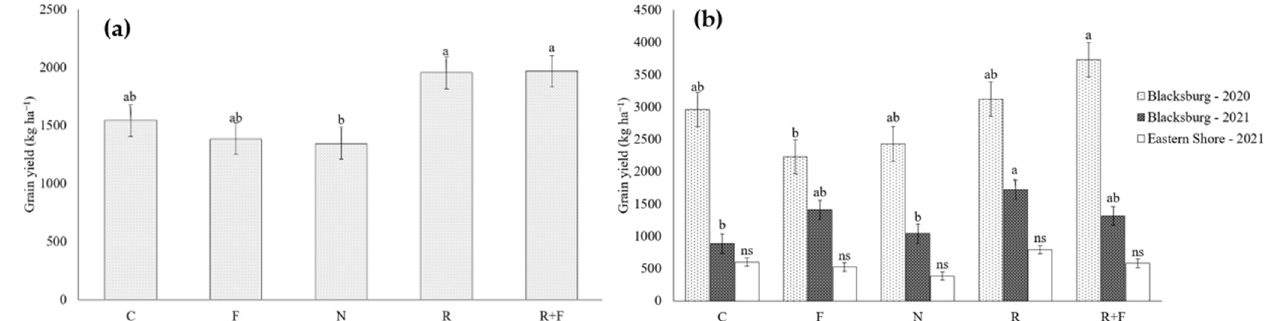
Figure 2. ( a ) Average grain yields from both locations and years by treatment. ( b ) Grain yields from each location by treatment. Mean comparisons are made between treatments at the respective location. Error bars represent the standard error for observations at each location. Treatments are labeled as follows: C = control, F = Arbuscular Mycorrhizal Fungi, N = Urea fertilizer, R = Bradyrhizobium spp., R + F = Dual inoculation with Bradyrhizobium spp. and Arbuscular Mycorrhizal Fungi. Treatments connected by different letters are significantly different at α = 0.10 according to Fishers protected LSD (n = 75). Treatment differences that are not significantly different are denoted by “ns” above the error bar.